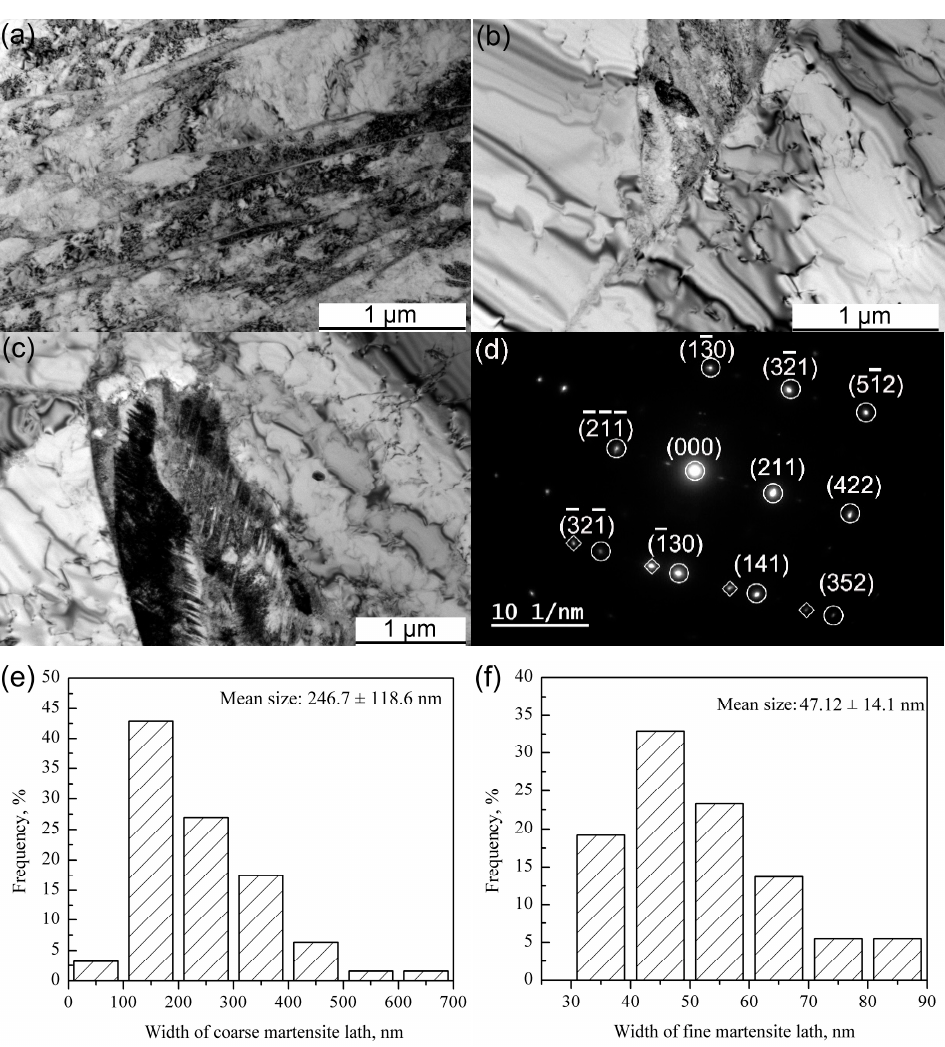
Figure 8. Transmission electron microscope (TEM) microstructure of the MP steel: ( a ) the coarse martensite lath; ( b ) grain boundary and the martensite lath; ( c ) fine martensite lath and ( d ) the corresponding selected area electron diffraction (SAED) pattern; width distribution of ( e ) coarse and ( f ) fine martensite lath.